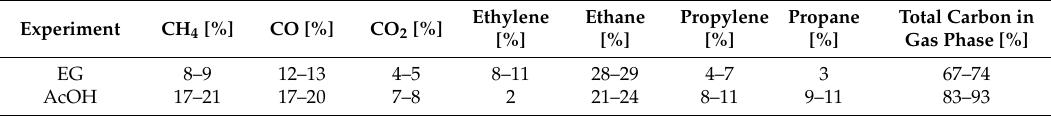
Table 4. Gas product yields at TOS = 0–2 h for the conversion of ethylene glycol (EG) and acetic acid (AcOH) at 450 ◦